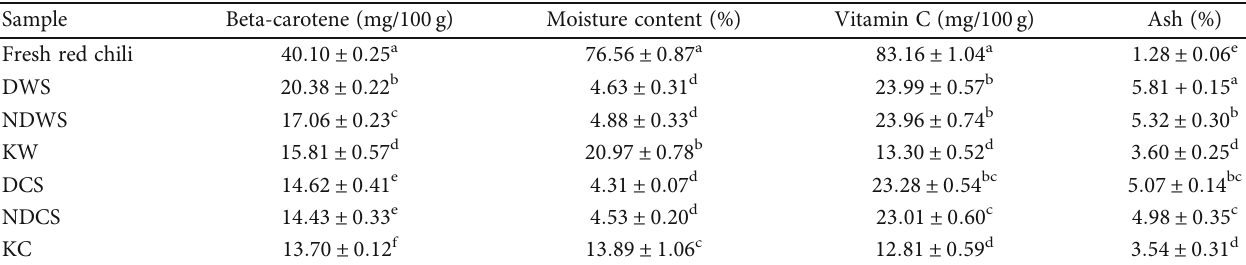
Mean ± SD values with di ff erent superscripts in a column are signi fi cantly di ff erent ( p ≤ 0 : 05 ). DWS: whole pods dried using desiccant in solar drying; NDWS: whole pods dried without using desiccant in solar drying; KW: whole pods dried using natural convection solar drying; DCS: half chili pods dried using desiccant in solar drying; NDCS: half chili pods without using desiccant in solar drying; KC: half chili pods dried using natural convection solar